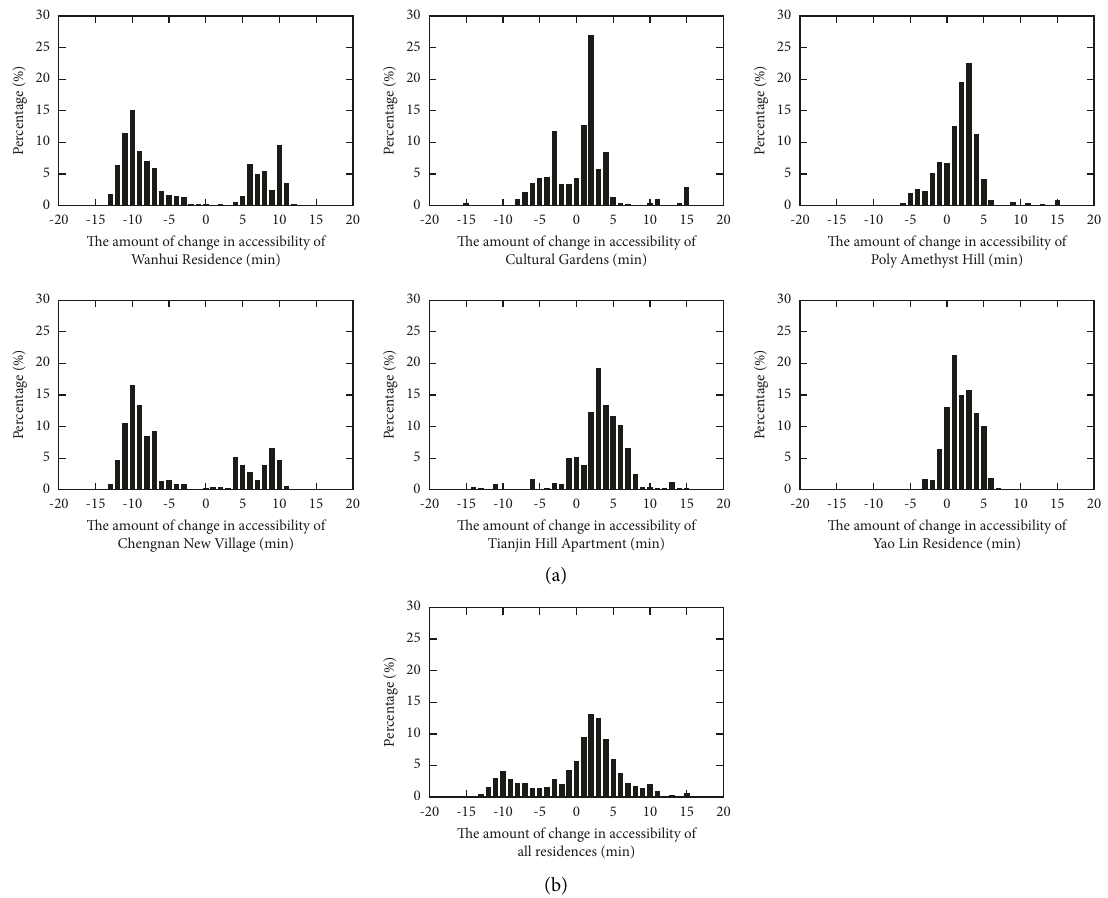
Figure 3: Frequency distribution of the amount of variation in temporal accessibility for each residential district (a) and all residential districts (b). (a) Various residential communities. (b) All residential